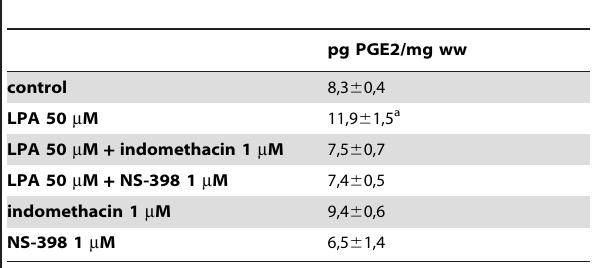
Table 4. Effect of LPA and COX inhibitors on the production of